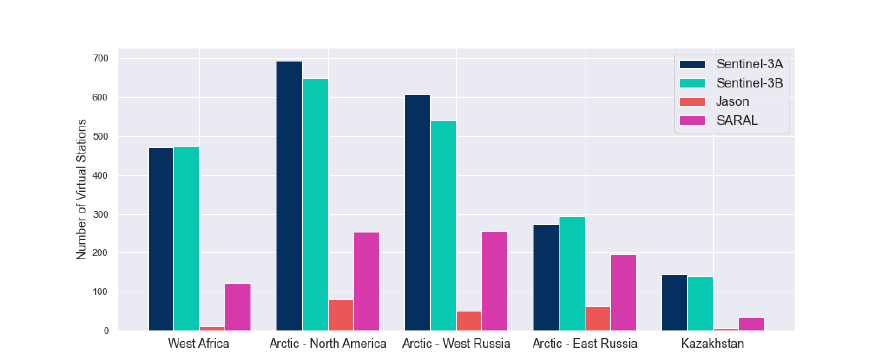
Figure 5. Virtual station counts by mission in each region.